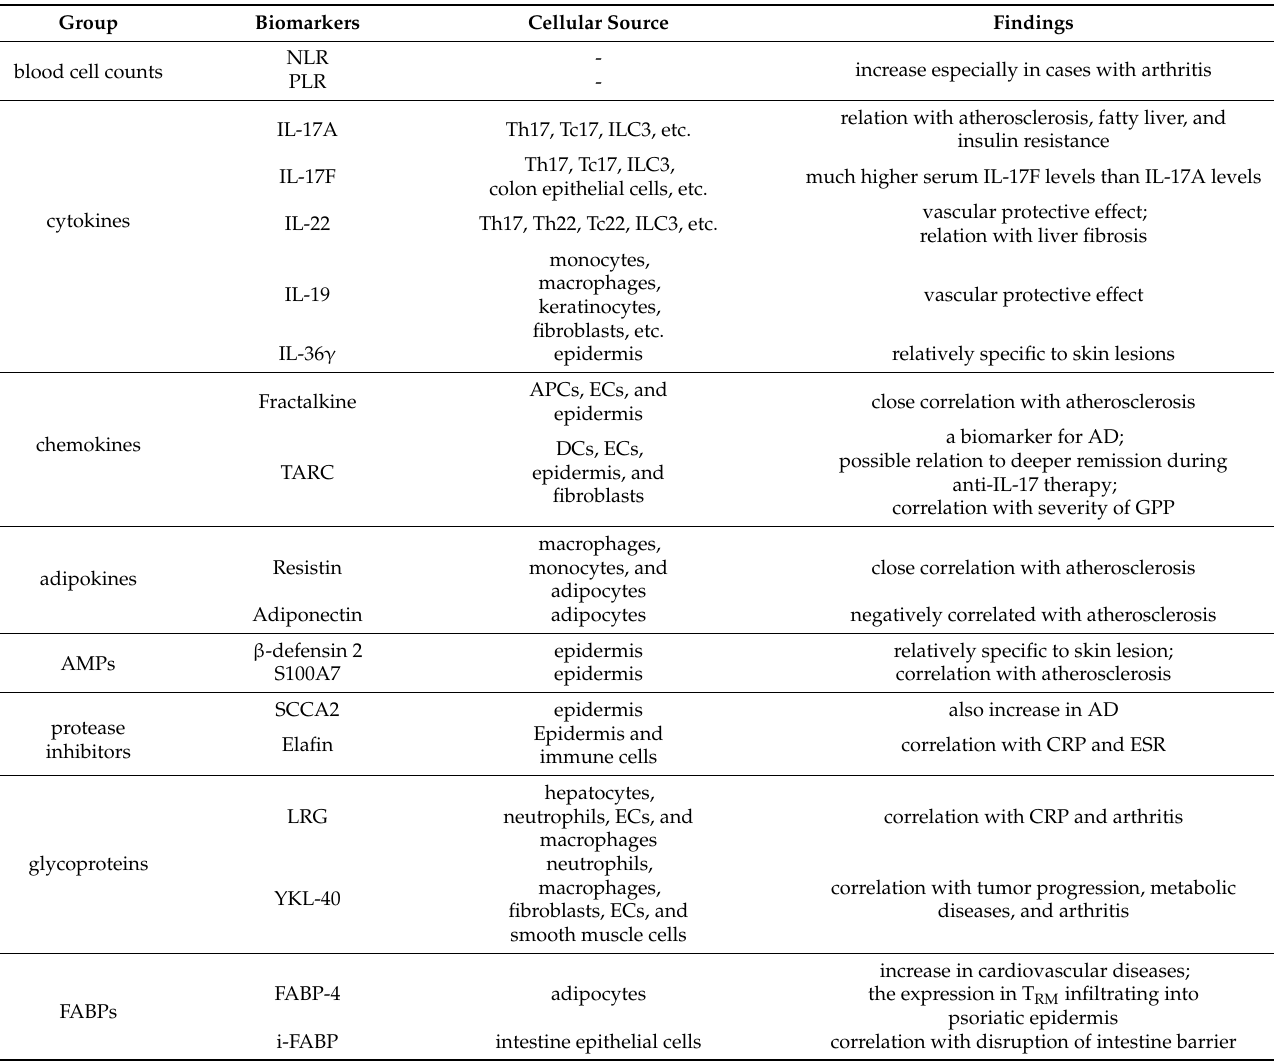
Table 1. Summary of blood-protein biomarkers reflecting the severity of